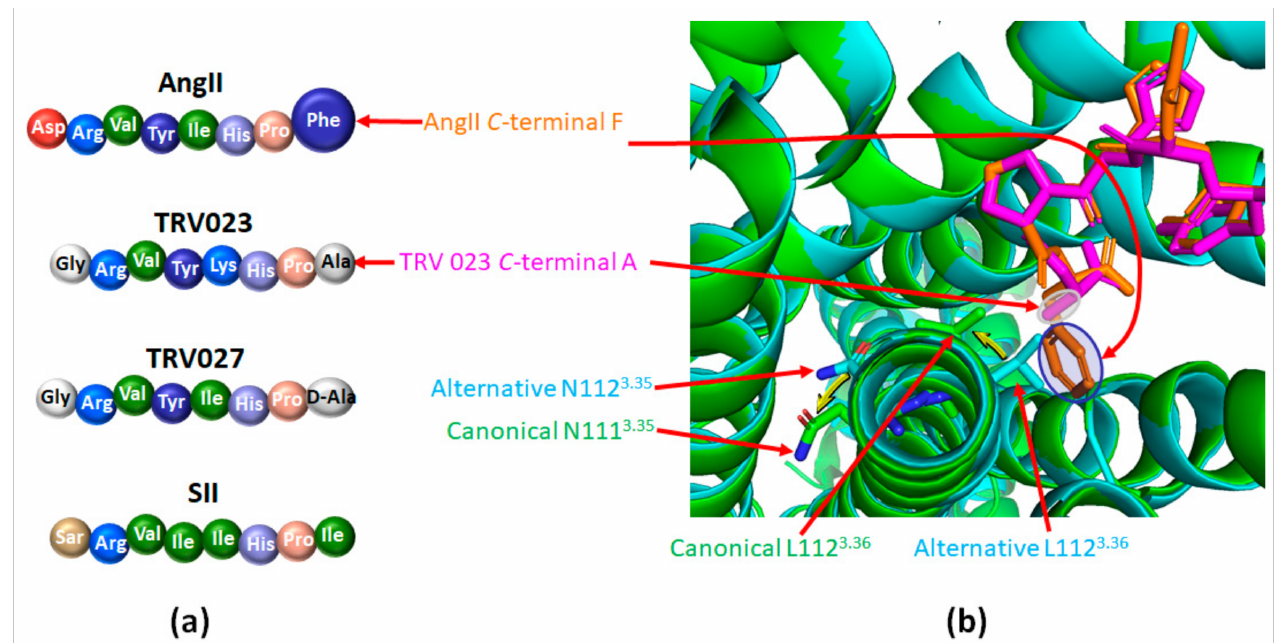
Figure 6. β -arrestin biased agonists of AT 1 favor its alternative active conformation. ( a ): Comparison of the amino acid sequences of angiotensin II (Ang II) and of the main β -arrestin biased agonists of AT 1 ; Ang II: angiotensin II; SII: [Sar 1 ,Ile 4 ,Ile 8 ] angiotensin II peptide analog; TRV023 and TRV027: β -arrestin biased AT 1 agonists. ( b ): Superimposition of the structure of AT 1 bound to Ang II (green, PDB code 6OS0; Ang II appears in orange) or to the β -arrestin biased agonist TRV023 (cyan, PDB code 6OS1; TRV023 appears in purple). The phenyl group of the C-terminal part of Ang II (highlighted in blue) goes deep into the ligand pocket, inducing a rotation of L112 3.36 and of N111 3.35 (yellow arrows). It yields the canonical structure of AT 1 (appears in green). The C-terminal part of TRV023 comprises a less bulky alanine residue (highlighted in grey) which does not induce such motion, yielding the alternative structure (in cyan). This